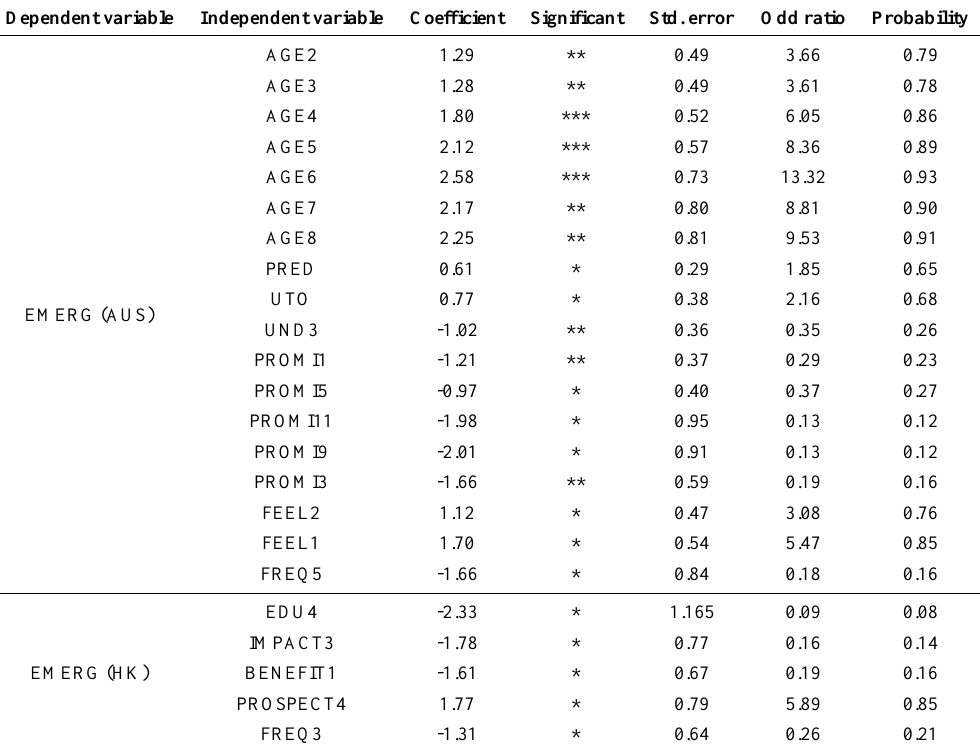
Table A-6. Disaster/emergency prediction and management